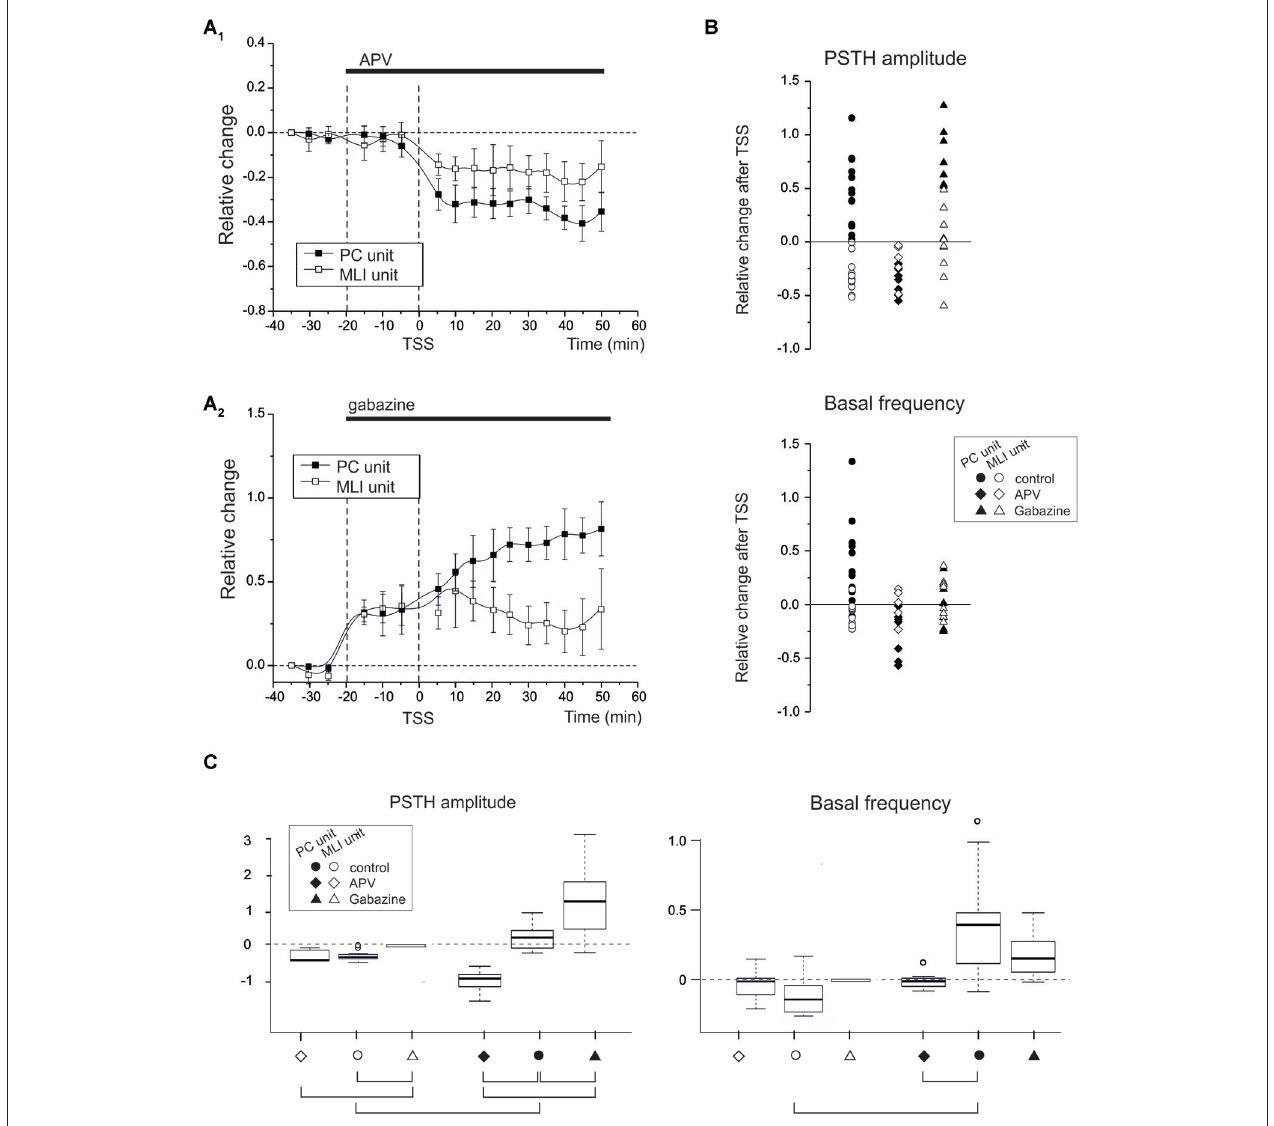
FIGURE 4 | NMDA and GABA receptor blockage differentially affect PC and MLI spike-related plasticity. (A 1 ) APV superfusion turns SR-P into SR-S in PCs but does not influence SR-S of MLIs. Average time course of changes (mean ± MSE) in PCs ( n = 7) and MLIs ( n = 5). (A 2 ) Gabazine superfusion does not prevent SR-P in PCs but prevents SR-S in MLIs. Average time course of changes (mean ± MSE) in PCs ( n = 8) and MLIs ( n = 8). (B) Changes in individual units after TSS both for peak PSTH amplitude changes and for basal frequency changes. The different data sets compare control (as in Figure 2 ) to APV and gabazine (as in A ). The values for APV and gabazine data sets are calculated with respect to the previous drug application period. (C) Boxplot representation and oneway ANOVA on the samples reported in (B) . The Tuckey post hoc test demonstrates significant differences between conditions (solid connectors). For PSTH amplitude : control PC vs. control MLI ( p < 0.0002), control vs. APV in PC ( p < 0.0007), control vs. gabazine in PC ( p < 0.02). For basal frequency : control PC vs. control MLI ( p < 0.01). Other diffenrences were not statistically significant (dashed